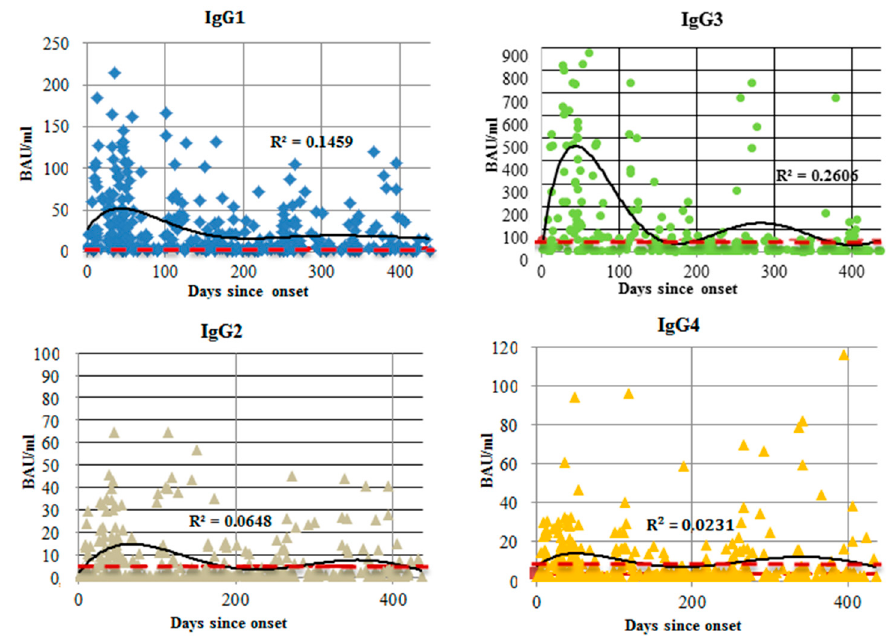
Figure 2. Total anti-N protein IgG antibody dynamics (ELISA) by subclass, as a function of time since COVID-19 onset for 348 individual patients. The range was from 1 to 438 days. Concentration is presented in BAU/mL. The red line represents the cut-off value for this specific subclass. The black line is the trend, and R 2 value is shown on each graph.